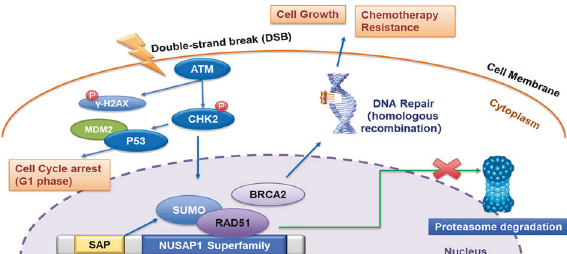
Fig. 7 Diagram of the mechanism of NUSAP1 promoting DNA repair process by binding with RAD51. RAD51 bound with the C-terminus of NUSAP1, meanwhile the SAP domain at the N-terminus of NUSAP1 may promote SUMOylation of RAD51, which prevented it from degradation, contributing to DNA damage repair pathway and promoting cancer cell growth or enhancing therapy